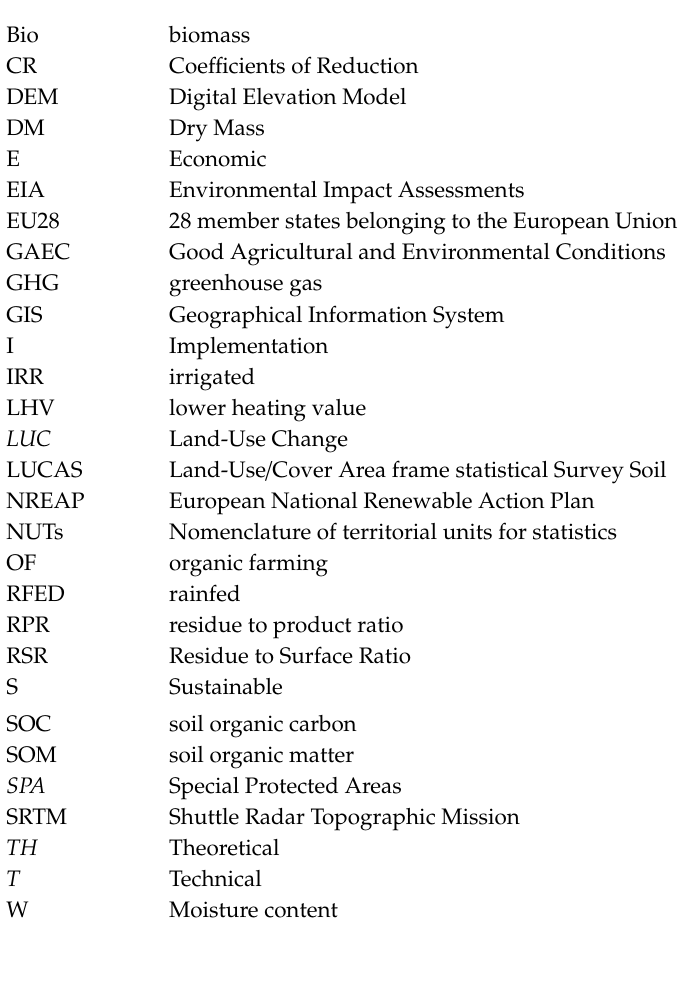
Figure S1: Regional theoretical pruning potential by NUTs2 level in EU28. Figure S2: Regional theoretical pruning potential by NUTs3 level in EU28. Table S1: summary of CRs and biomass potentials for EU28 by NUTs0. Table S2: summary of CRs and biomass potentials for EU28 by NUTs2. Table S3: summary of CRs and biomass potentials for EU28 by